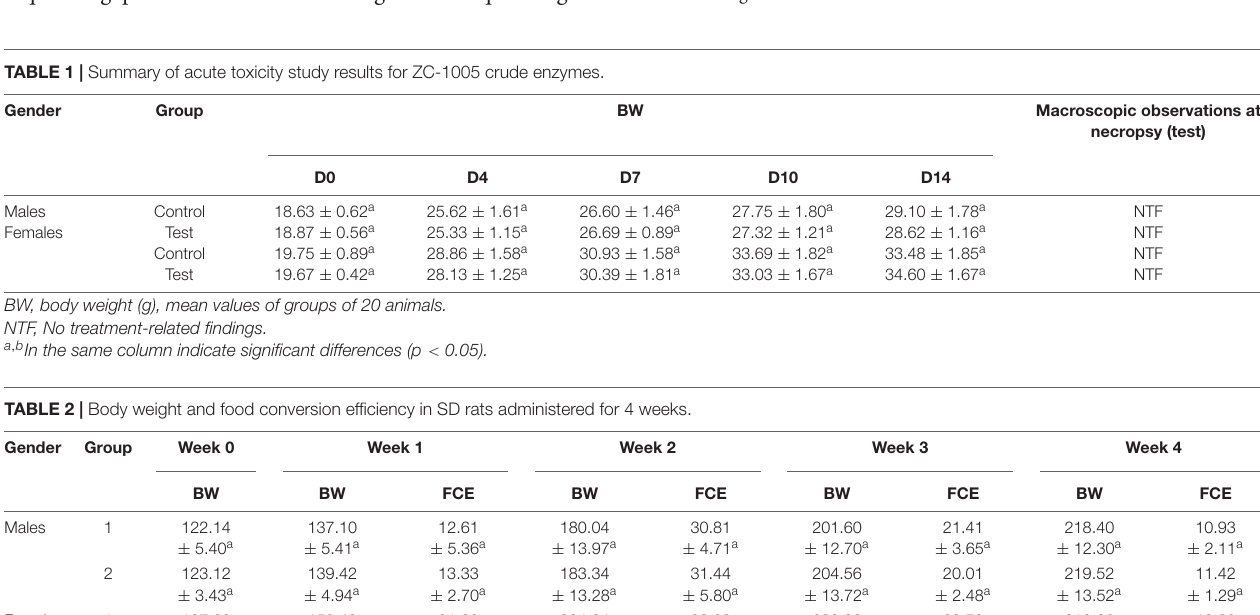
TABLE 1 | Summary of acute toxicity study results for ZC-1005 crude enzymes. Gender Group